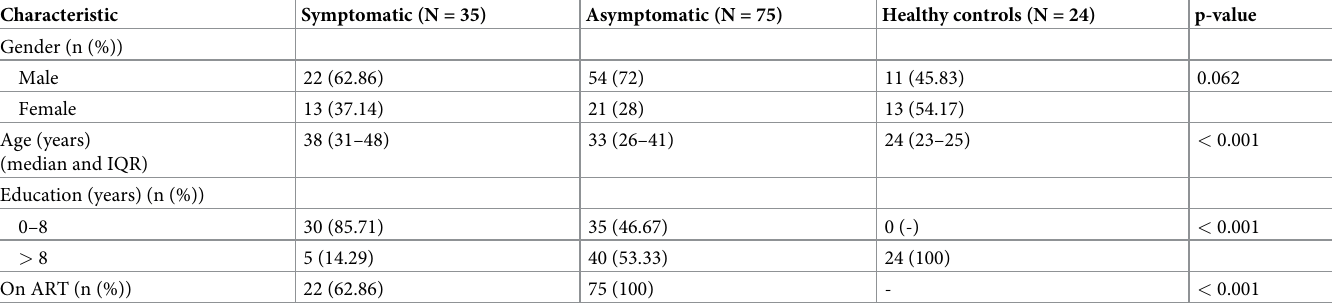
Table 1. Comparison of demographic characteristics between groups (univariate analysis) from Pernambuco, Brazil.